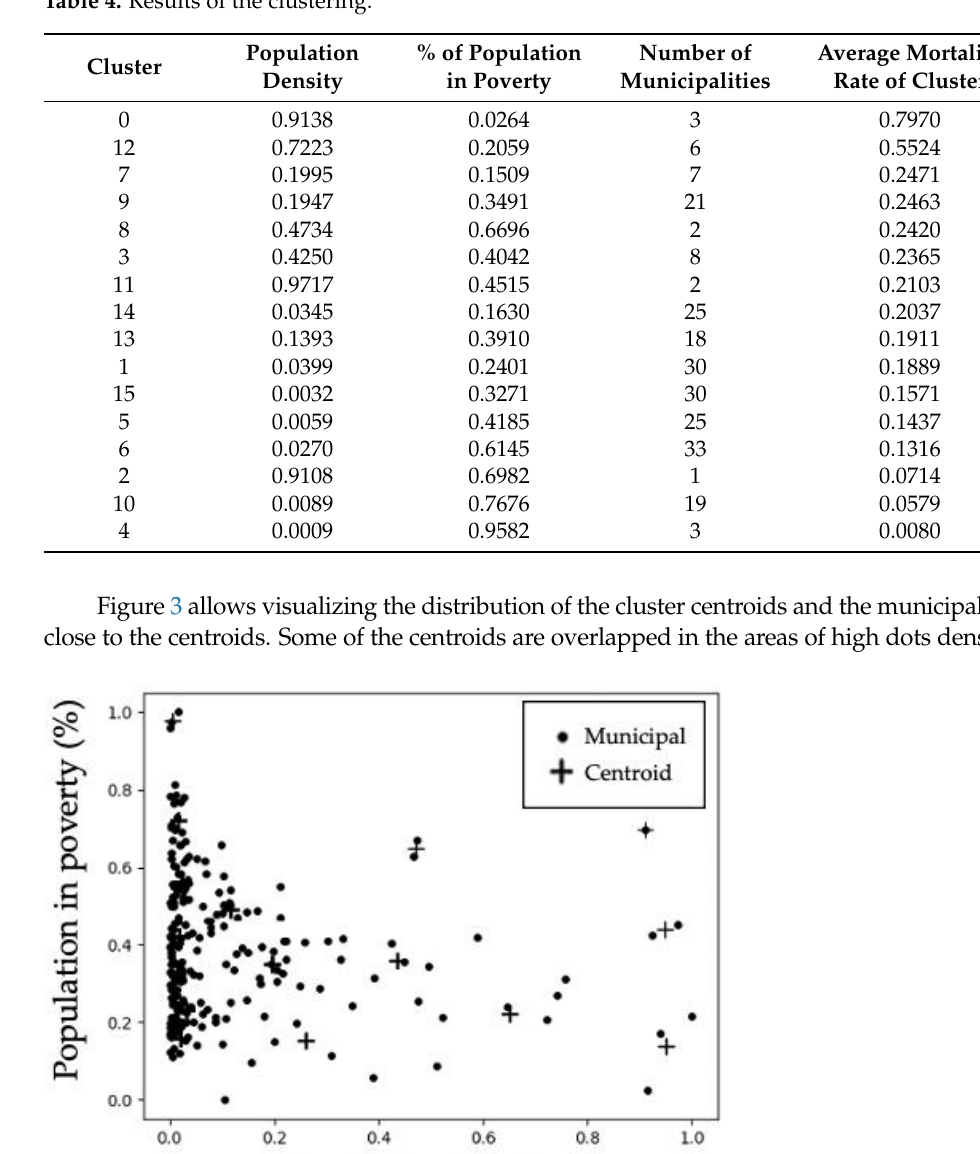
Table 4. Results of the clustering.